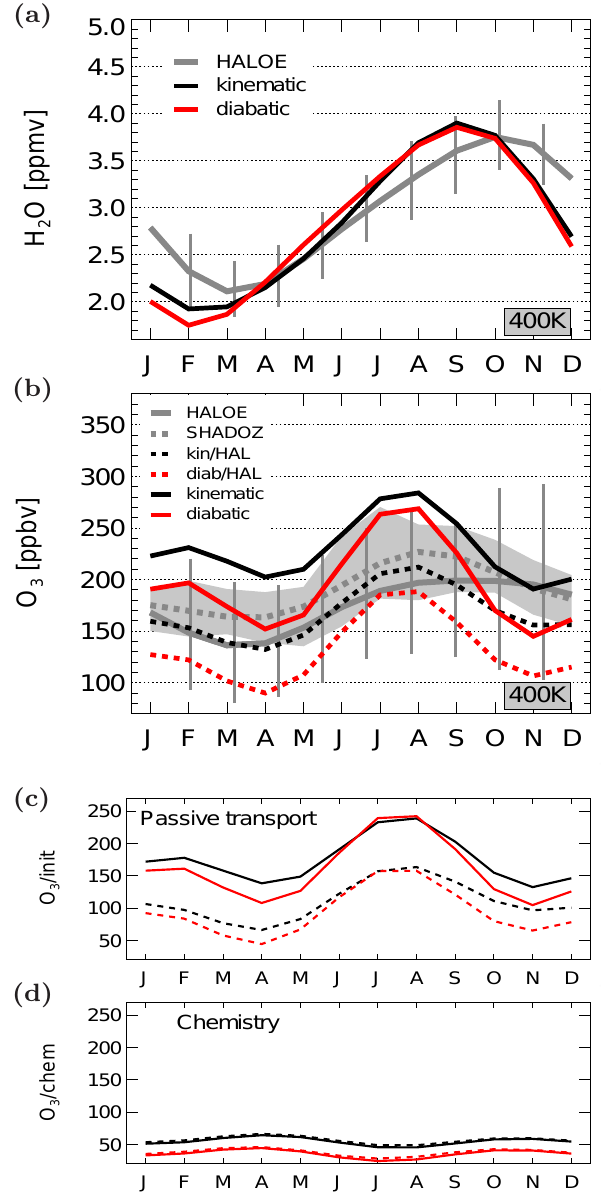
Fig. 2. Monthly mean, tropical mean (20 ◦ S–20 ◦ N latitude) mix- ing ratios at 400K for (a) water vapour and (b) ozone from HALOE (averaged for years 2001–2005; grey solid lines, with range of ± 1- standard deviation as vertical bars), and from SHADOZ (1998– 2006; for ozone only, grey dotted line and grey shading for range of ± 1-standard deviation). The model predictions based on initialisa- tion with ERA-Interim are shown as solid lines, and with initialisa- tion based on HALOE as dashed lines (for ozone only); calculations based on kinematic trajectories in black, diabatic trajectories in red. (c) Predicted ozone concentrations based on initial conditions only (i.e. passively advected ozone); same conventions as in (b) . (d) Predicted ozone concentrations based on chemistry along trajecto- ries; same conventions as in (b) . All lines are harmonic fits to the monthly mean values, using annual and semi-annual